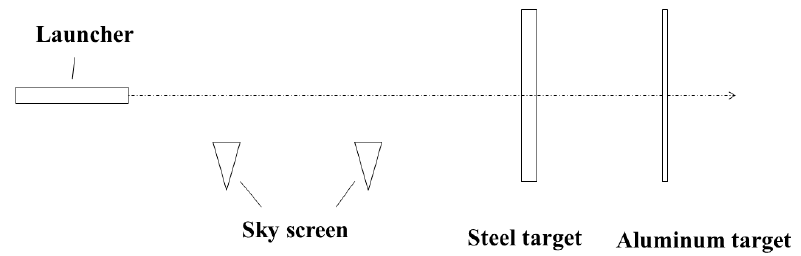
Figure 8. Experimental site layout.